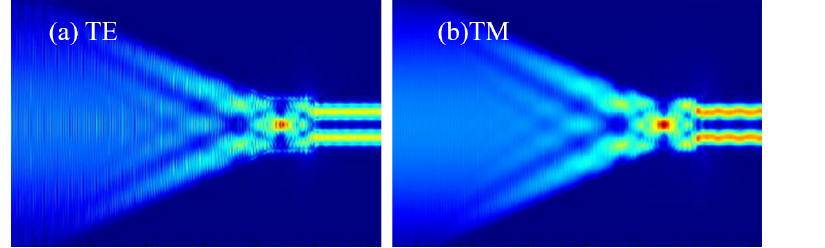
Figure 3. Energy distribution for both polarizations of the 1 × 2 beam splitter.